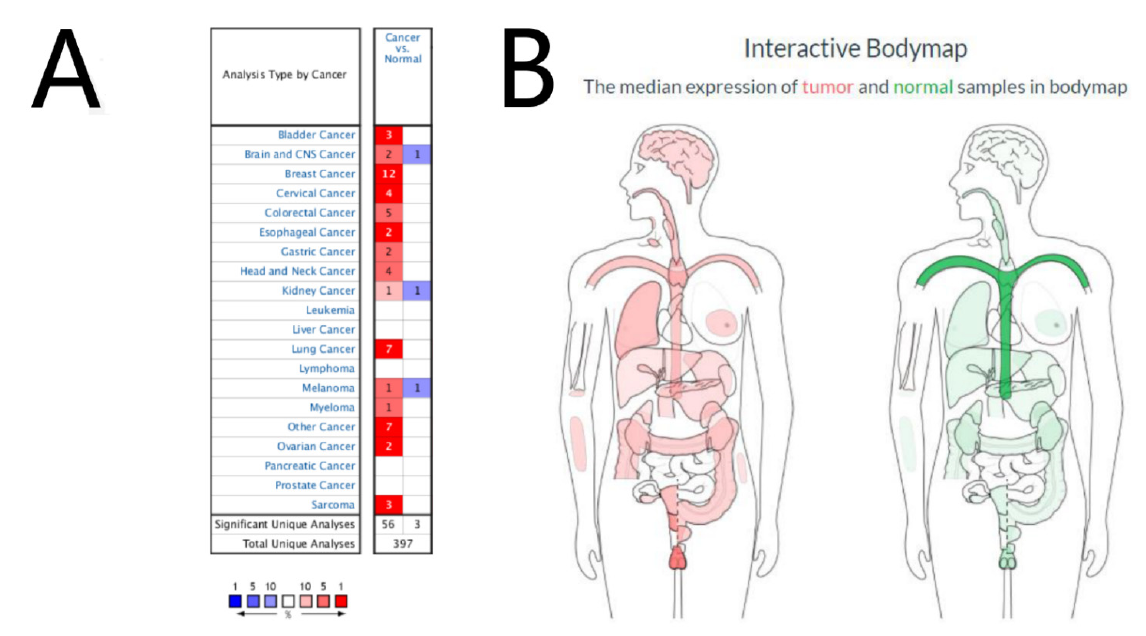
Figure 1. Expression profile of the Timeless gene in different human tissues. ( A ) Expression of Timeless in different types of cancer from the Oncomine database. ( B ) Median expression of tumor and normal samples in the bodymap from the GEPIA database.